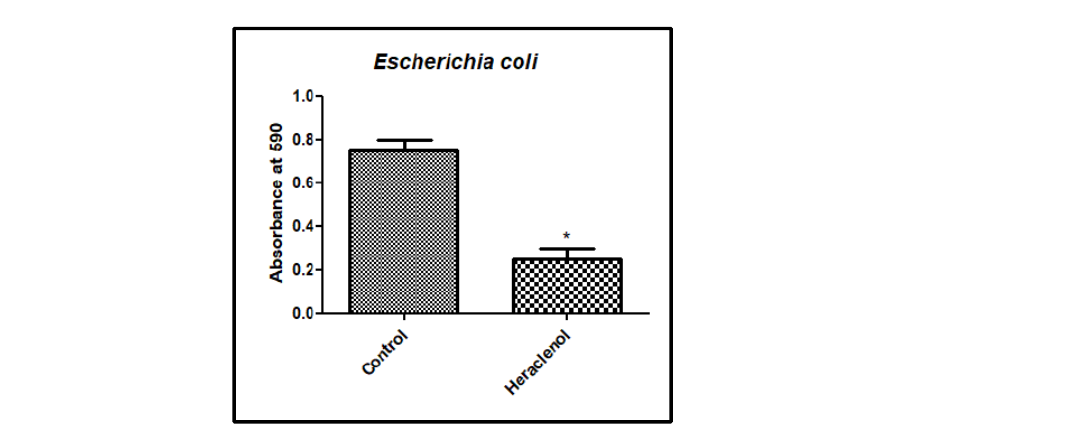
Figure 6. Heraclenol’s effect on biofilm formation. Biofilms were stained with crystal violet. * p , 0.05; comparison by Student’s t -test in Graph pad prism.